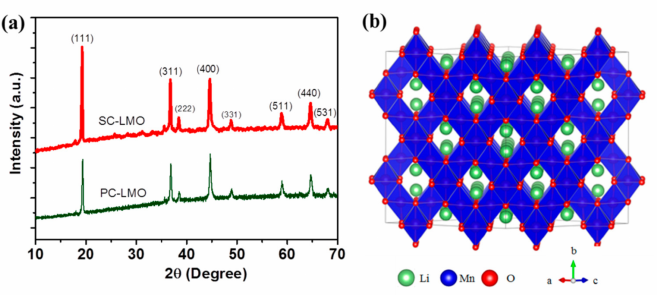
Figure 1. ( a ) Powder XRD patterns of single-crystal LiMn 2 O 4 and polycrystalline LiMn 2 O 4 . ( b ) Crys- tal structure of spinel LiMn 2 O 4 .